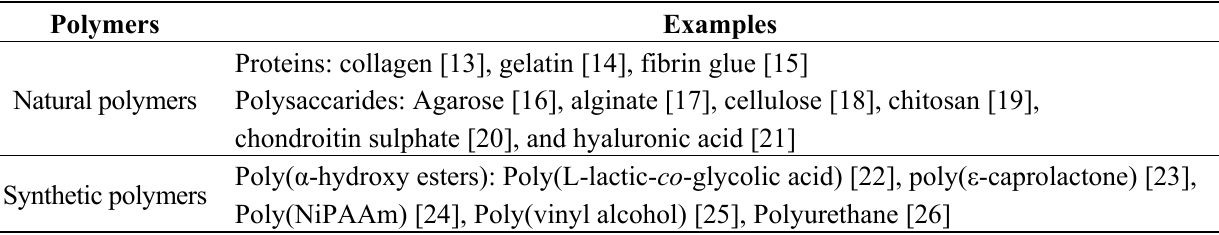
Table 1. List of some natural and synthetic polymers have been extensively surveyed for cartilage tissue